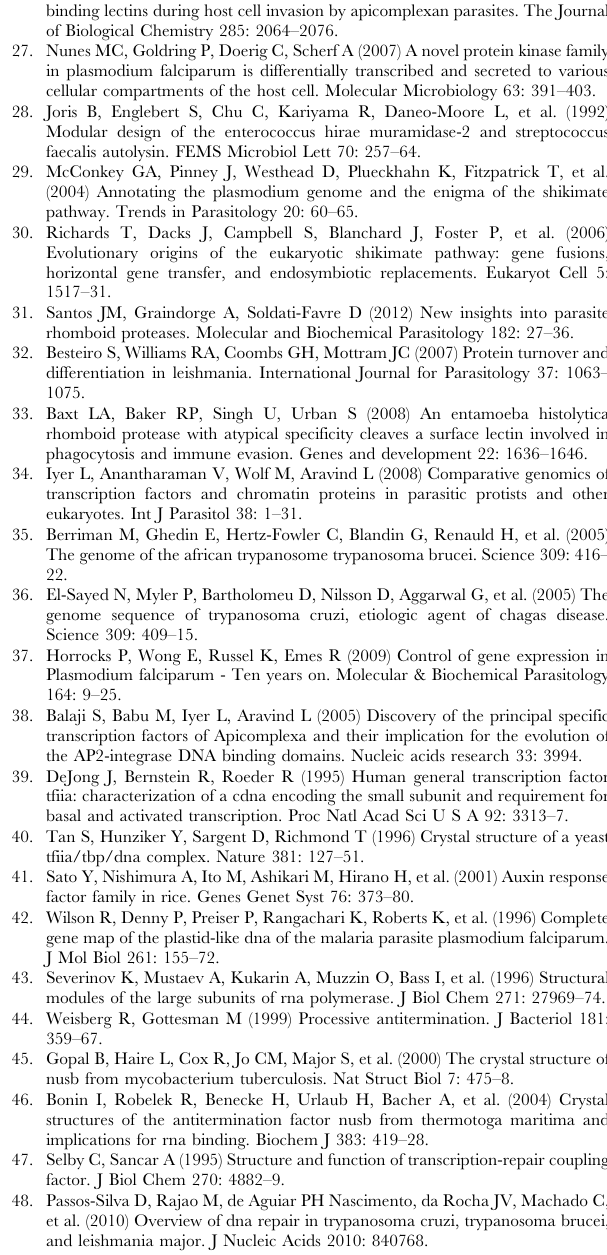
Table S3 List of the 37 L. major domain predictions that were manually analysed. Table S4 List of all predicted domains in P. falciparum . Table S5 List of all predicted domains in L. major